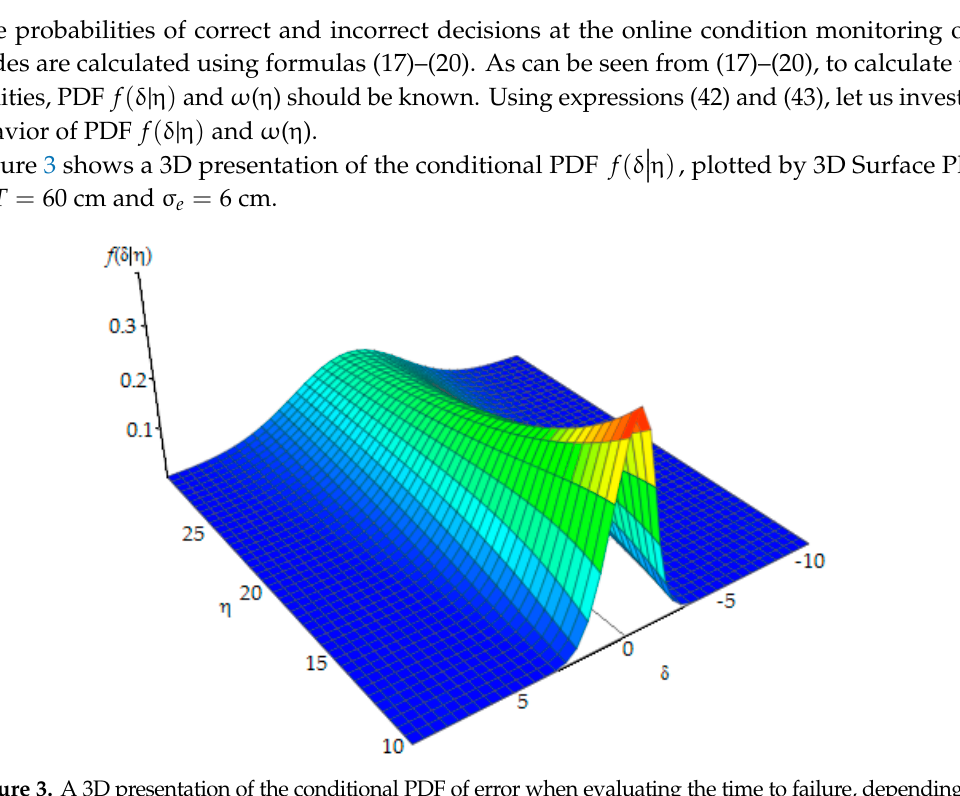
Figure 3. A 3D presentation of the conditional PDF of error when evaluating the time to failure, depending on the arguments δ and η . on the arguments δ and η